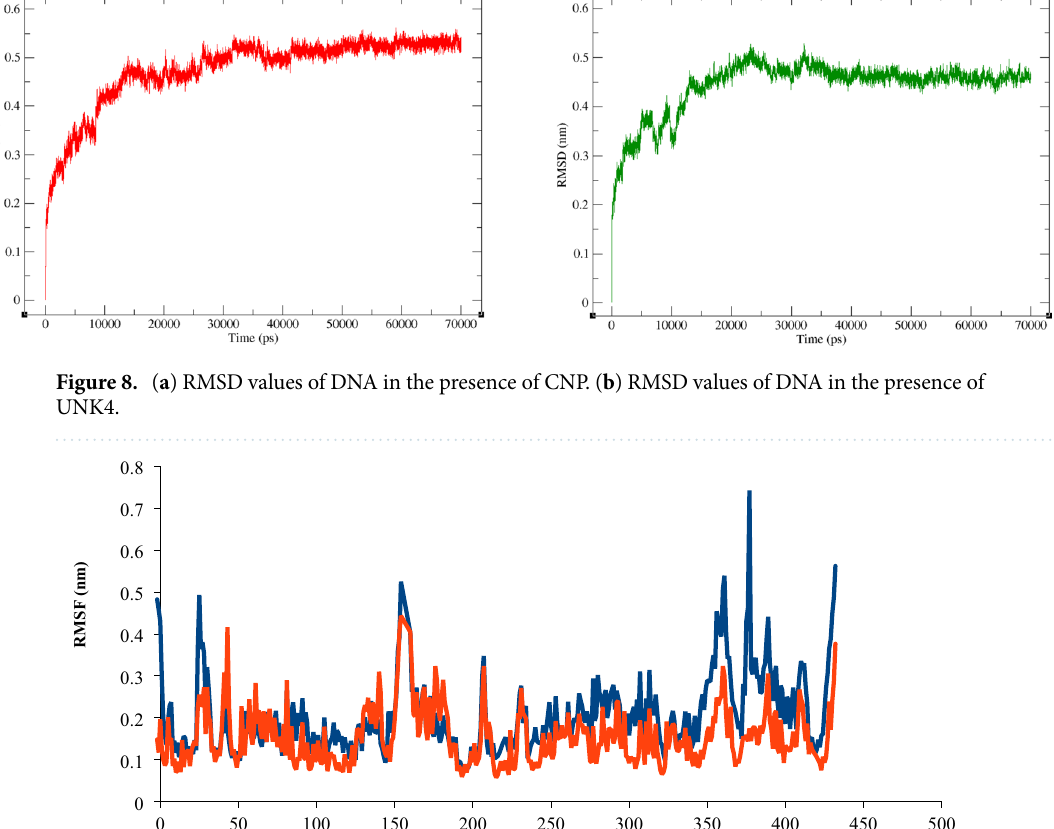
Figure 9. RMSF plots of the protein backbone Polη complexed with CNP (series 1, blue plot) and UNK4 (series 2, red plot) during 70 ns MD